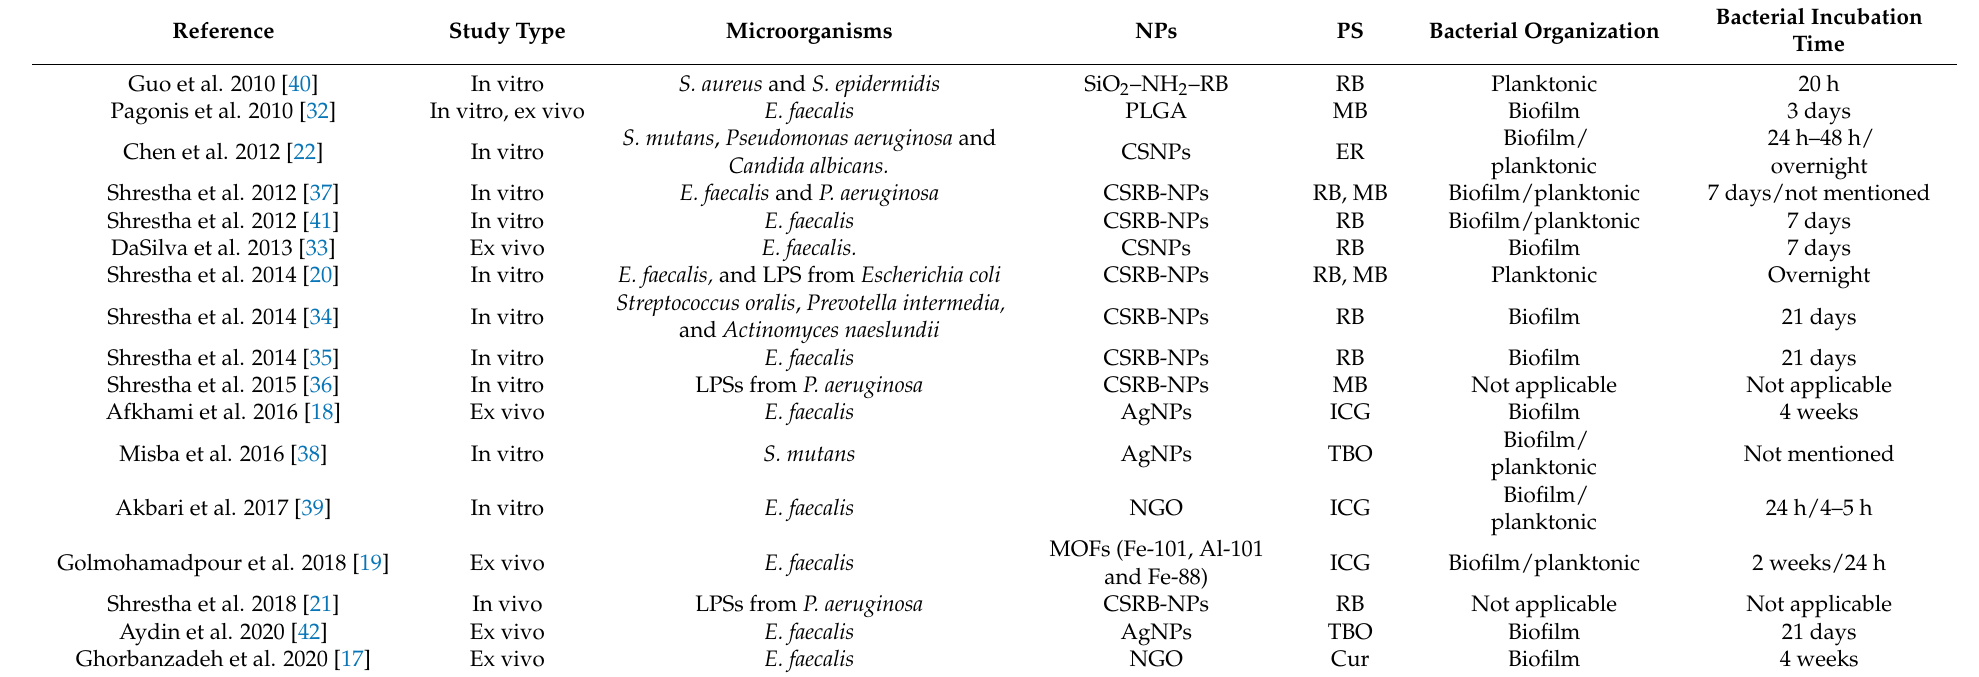
Table 1. Summary of studies